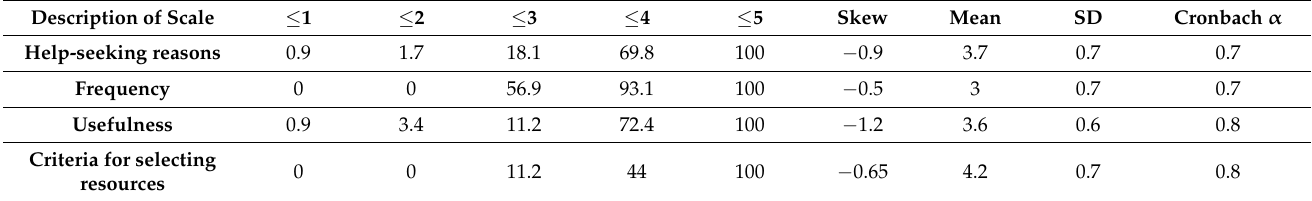
Table 6. Distribution and internal consistency of help-seeking reasons and criteria for selecting